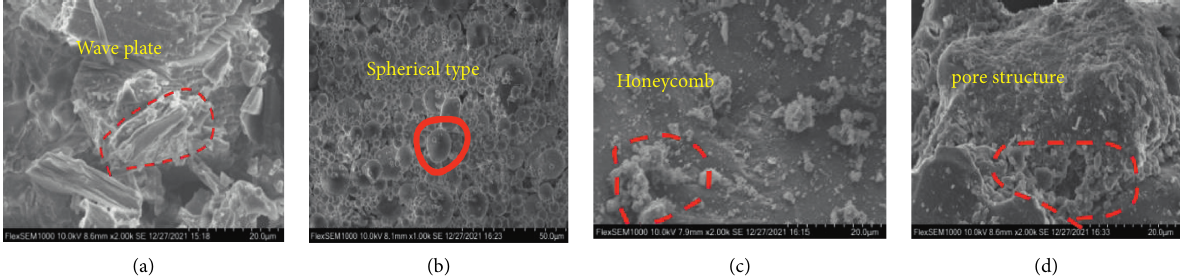
Figure 9: SEM structure before multisource coal-based solid waste proportioning experiment. (a) Desulfurized gypsum. (b) Fly ash. (c) Gasification slag. (d) Furnace bottom